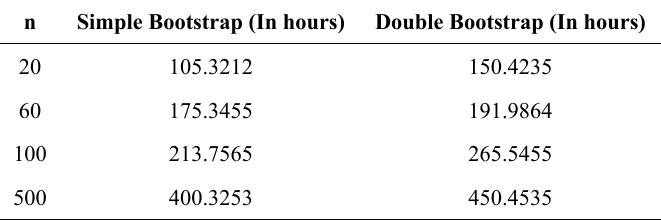
Times of executions of Monte Carlo simulations to evaluate the interval estimates obtained by single and double percentile